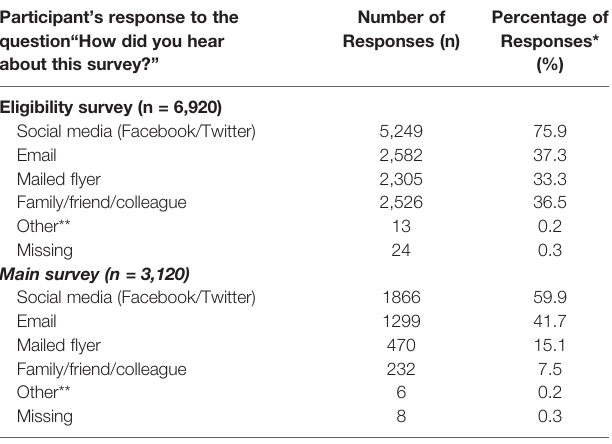
TABLE 2.1 | Survey respondents from eligibility screener and pre-cleaned main survey responses. Participant ’ s response to the question “ How did you hear about this survey? ”